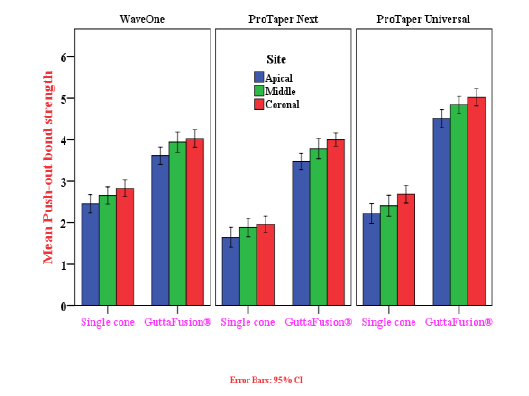
Figure 7: The mean value of push-out bond strength of two obturation